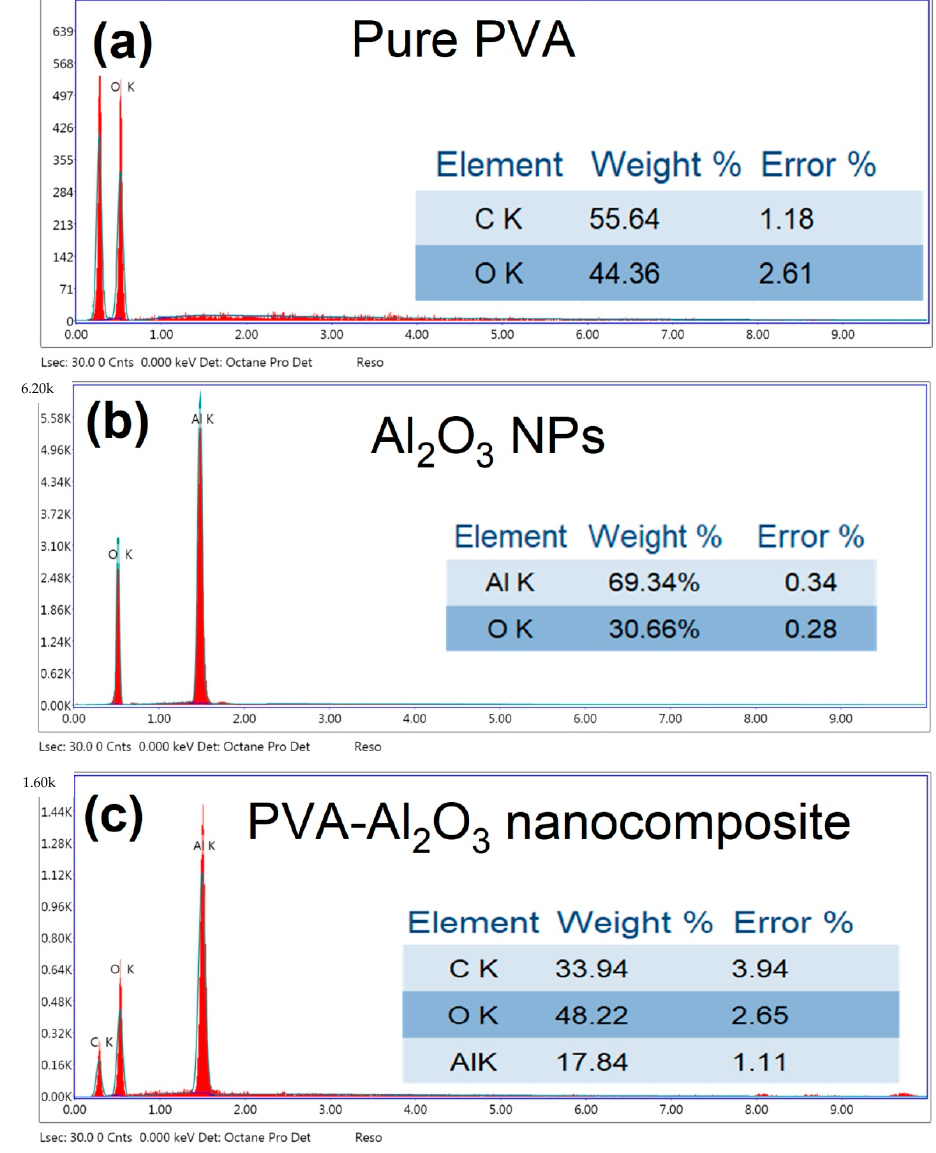
Figure 4. EDX elemental analysis of ( a ) PVA and ( b ) EDX elemental analysis of PVA before and ( c ) after embedding with Al 2 O 3.